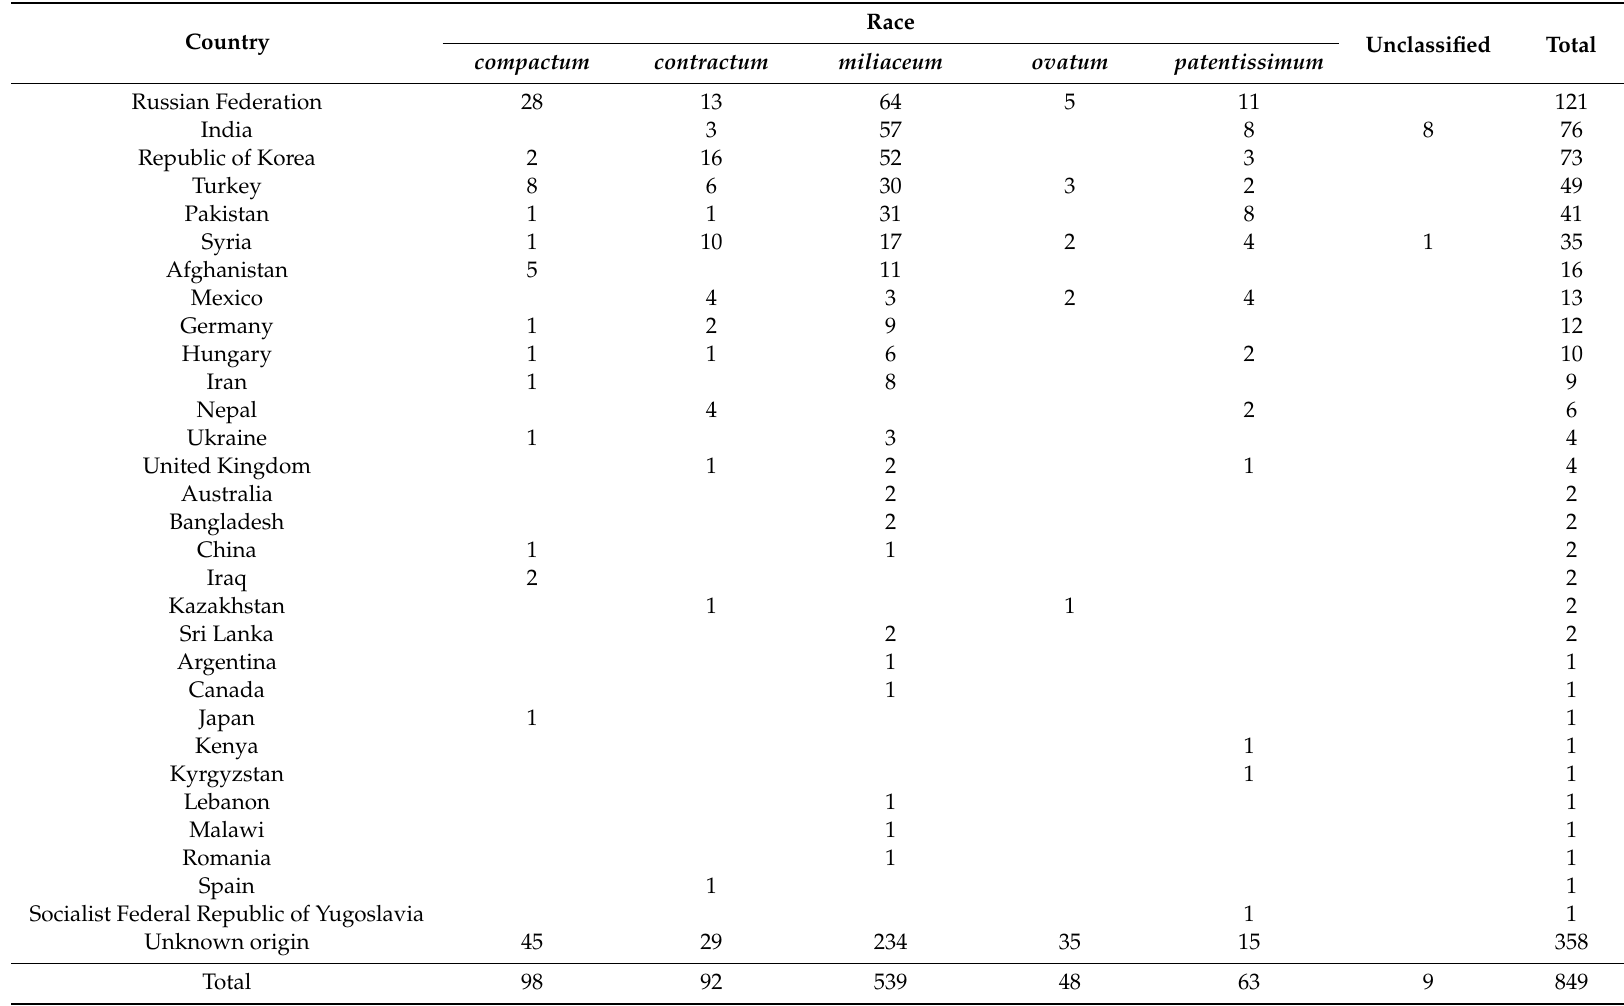
Table 1. Proso millet germplasm conserved at the International Crops Research Institute for the Semi-Arid Tropics (ICRISAT) genebank, Patancheru, India. Race Country